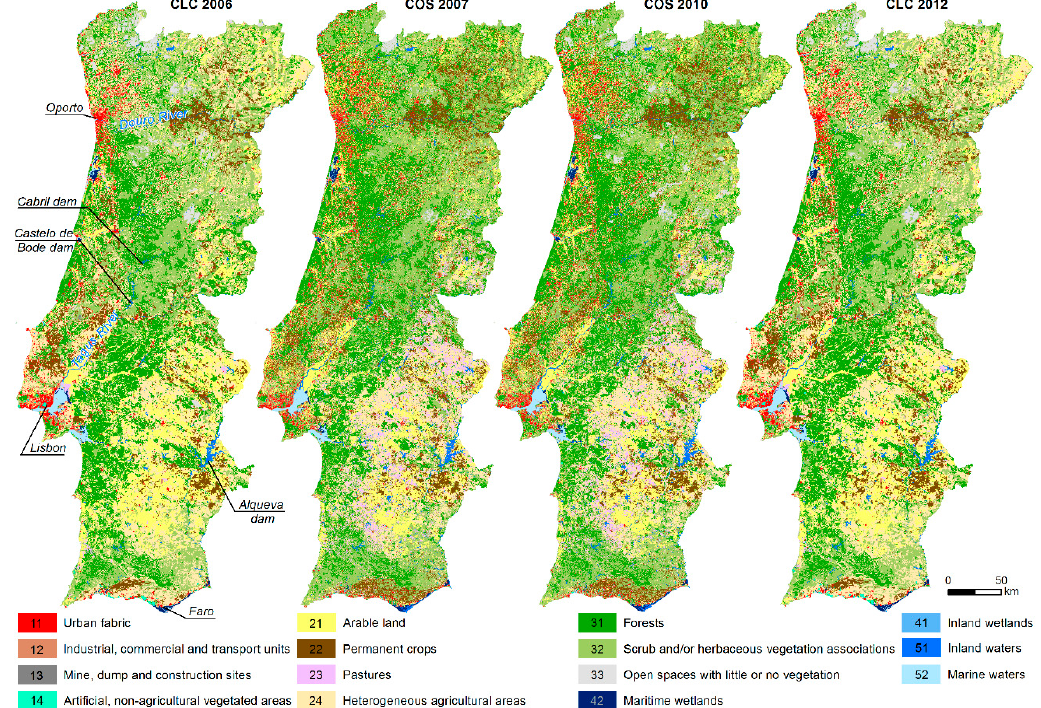
Figure 1. Land use and land cover of mainland Portugal in different years ( Carta de Ocupação do Solo (COS) and Corine Land Cover (CLC) geoinformation, source: General Directorate for Territorial Development (DGT)).